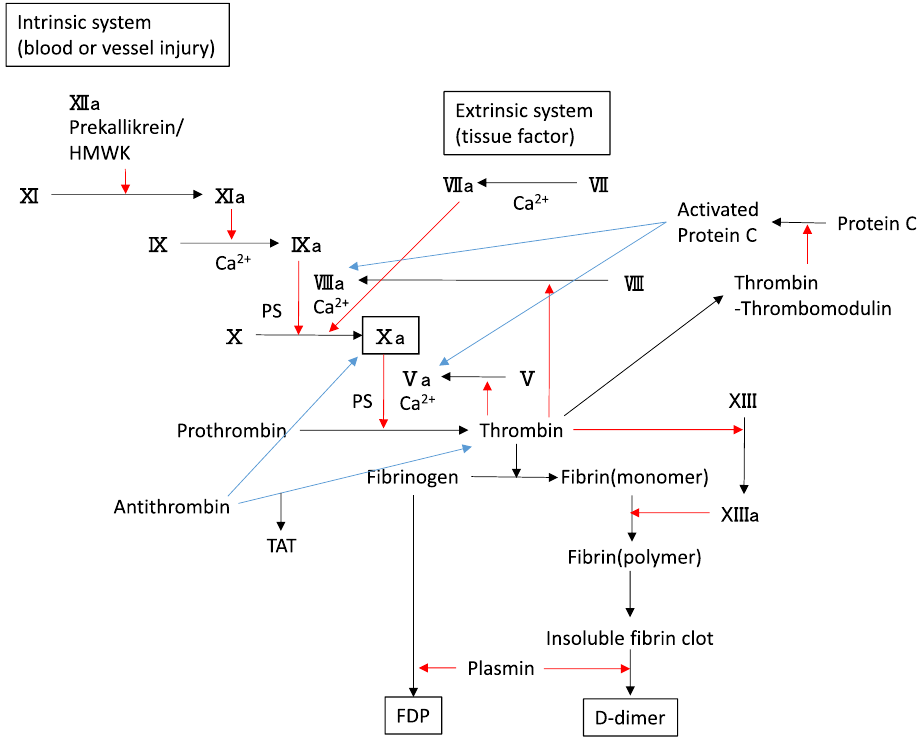
Figure 3: The coagulation cascade. Red arrows indicate activation, and blue arrows indicate inactivation. TAT, thrombin - antithrombin complex; HMWK, high molecular weight kininogen; PS,